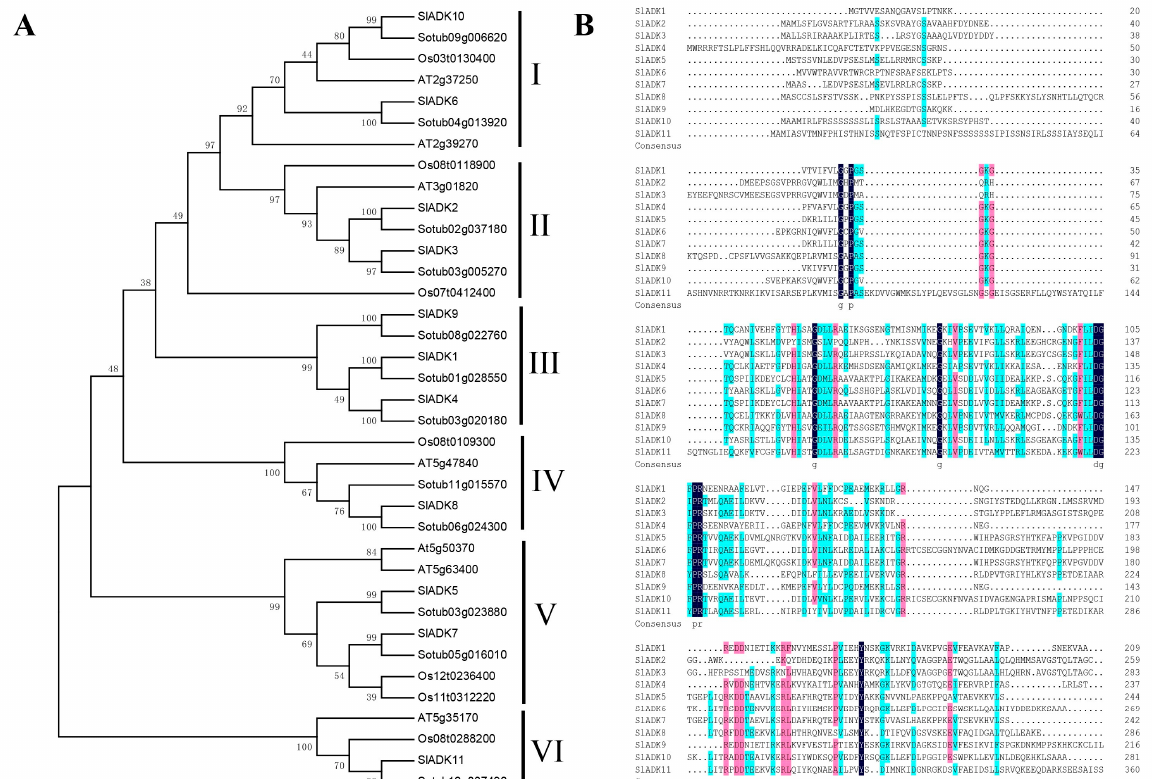
Figure 1. Phylogenetic analysis and multiple sequence alignment of adenylate kinase (ADK). ( A ) Phylogenetic analysis of tomato ADK family members, together with 7 Arabidopsis ADKs, 12 potato ADKs, and 7 rice ADKs. Full length of ADK proteins in these species were aligned using ClustalW and phylogenetic trees was carried out by the neighbor-joining method on MEGA7. Numbers on branches are bootstrap values calculated from 1000 replicates. Each branch is marked out with Roman numerals. ( B ) Multiple sequence alignment of SlADKs. SlADK proteins were aligned using DNAMAN8 software. Highlight homology level in 100%, ≥ 75% and ≥ 50% with the colors of blue, pink and green, respectively.